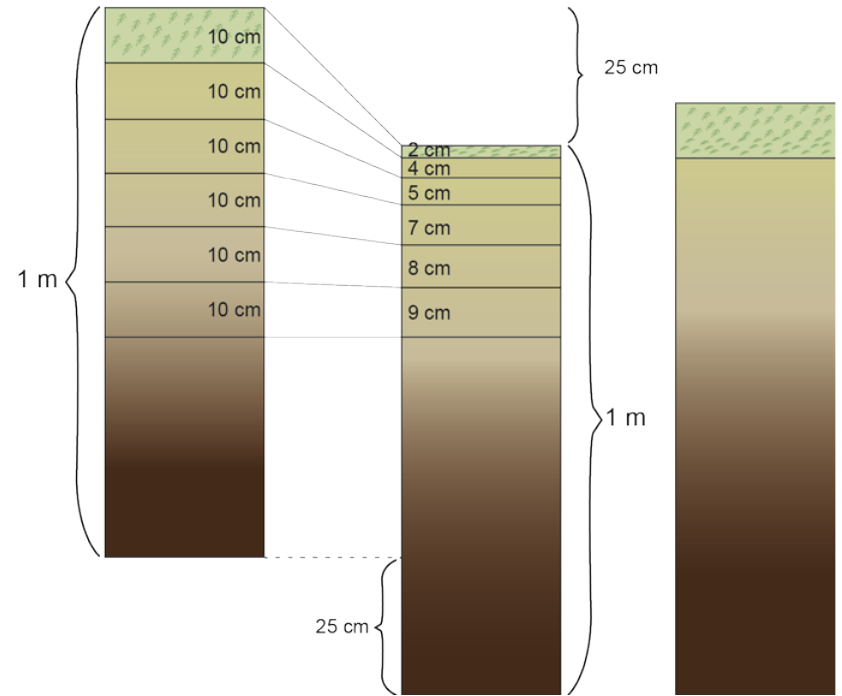
Figure 6. A theoretical example of how peat subsidence following drainage may affect the vertical structure of the peat and the pre-drainage layer sampled. The left-hand block represents the top metre of the peat column in its pre-drainage condition, and the middle block represents the top metre of peat at the same location after drainage. Subsidence is 25 cm and it is assumed that compaction is greatest in the topmost peat and decreases downwards, ending at 60 cm (pre-drainage). Assumed subsidence per 10-cm layer is 8 cm 10-cm -1 in the topmost layer, then 6, 5, 3, 2 and 1 cm 10-cm -1 . In this case, 60 cm of pre-drainage peat would correspond to only 35 cm of post-drainage peat. The right-hand block represents the drained peat column after subsequent accumulation of a litter layer as would occur, for example, if the peatland was drained for